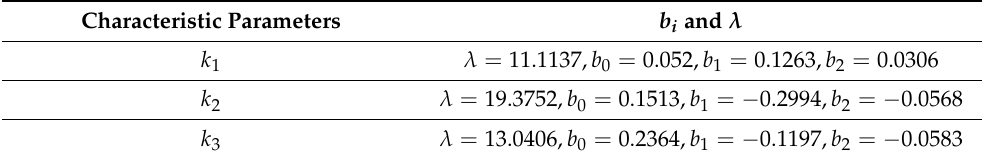
Table 4. Polynomial coefficients b i and λ .